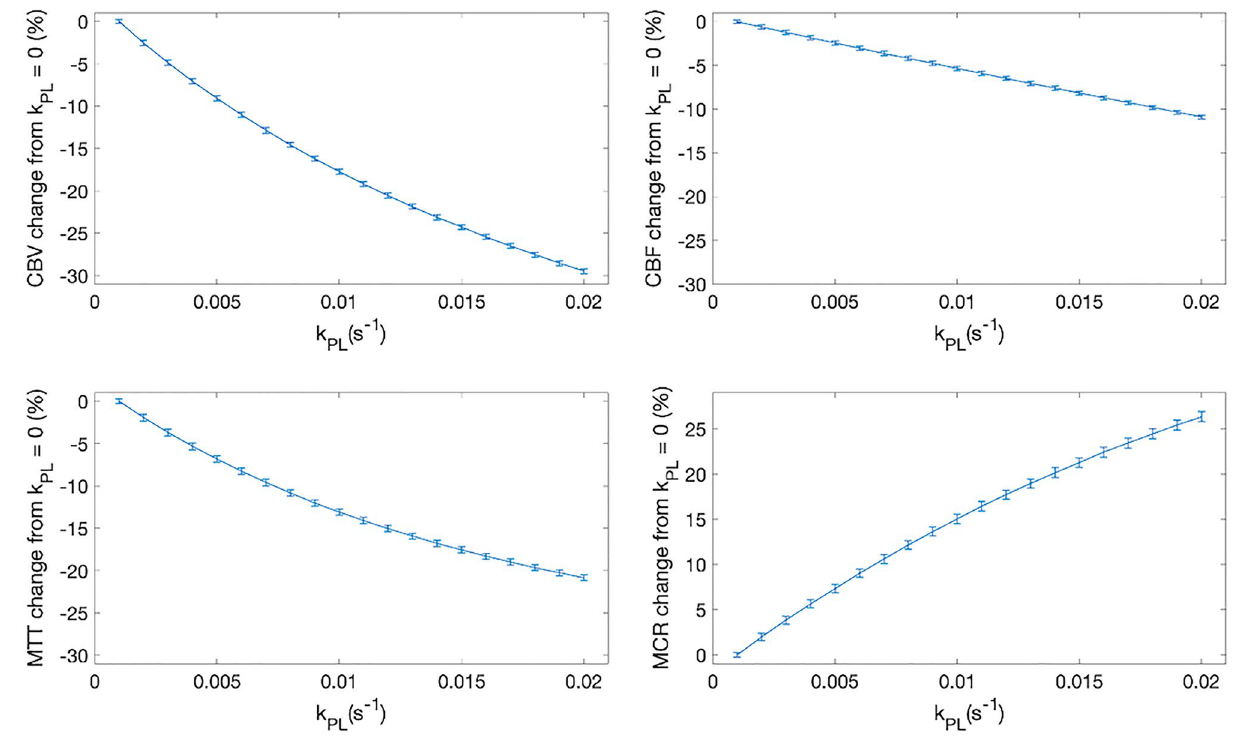
Figure 5. Simulation results demonstrating sensitivity of the model to k PL . T 1 pyruvate, B 1+ deviation, flip angle, and B